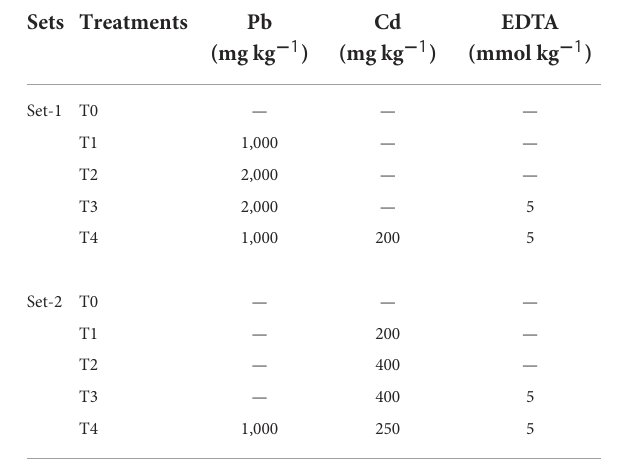
TABLE 1 Treatments used in set-1 and set-2.